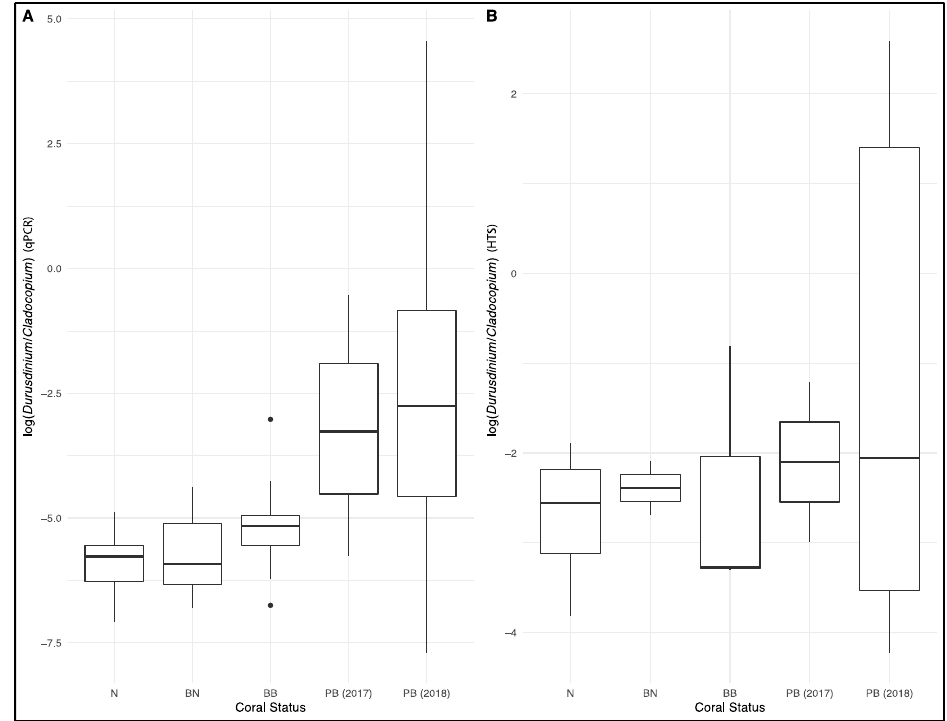
Figure 2. Ratios of Durusdinium to Cladocopium abundance in the five different coral groups (N: normal colonies in 2016, BN: normal portions of the bleached colonies in 2016, BB: bleached portions of the bleached colonies in 2016, PB (2017): post-bleaching colonies in 2017, PB (2018): post-bleaching colonies in 2018). ( A ) Ratios obtained from quantitative polymerase chain reaction (qPCR). ( B ) Ratios obtained from high-throughput sequencing (HTS; Illumina).